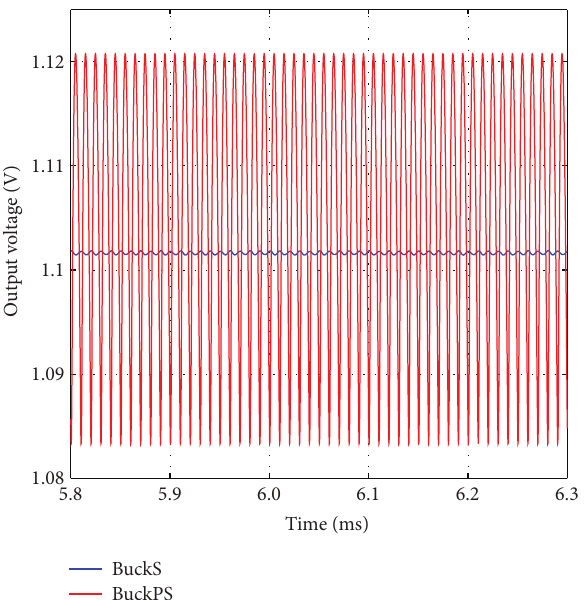
Figure 12: Dynamic behavior of the BuckPS output